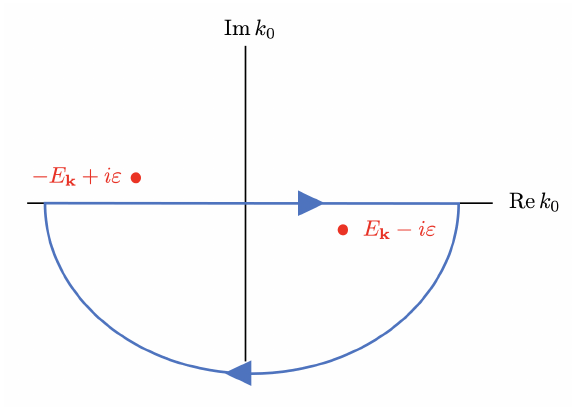
Figure 10: The integration contour in the complex k